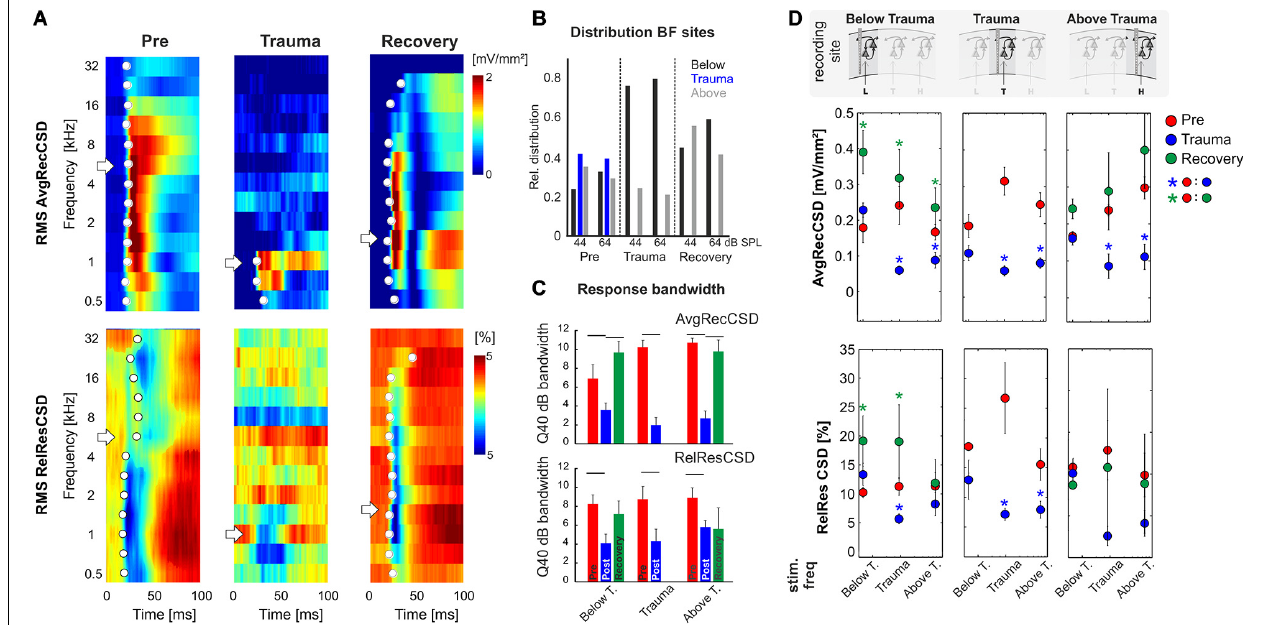
FIGURE 3 | (A) Representative example of AvgRecCSD (top) and RelResCSD (bottom) obtained after stimulation with varying sound frequencies at moderate sound level (64 dB SPL) prior to (left), after trauma induction (middle) and after 4 weeks of recovery (right). The respective BFs defined by the maximum AvgRecCSD peak amplitude are indicated by white arrows. Before trauma, the BF in the example was found to be 5.6 kHz. At the corresponding recording position, the BF after 4 weeks of recovery was decreased to 1.4 kHz. Onset latency of significant activation (2SD > baseline) at each sound frequency is indicated by white circle. (B) Distributions of the BF (based on granular sink S1 peak amplitude) determined at 44 as well as 64 dB SPL and measured at recording sites with BFs below, around and above the trauma frequency (bar colors) at the three time points directly before and after trauma induction as well as after 4 weeks of recovery. For Chi-Square-test results, see main text. (C) Response bandwidths before ( Pre ) and after ( Trauma ) the trauma and 4 weeks later ( Recovery ) measured by Q40dB values (in octaves) were calculated for the RMS values of the AvgRecCSD (top) and the RelResCSD (bottom). (D) Quantitative comparison of RMS values of AvgRecCSD (top) and RelResCSD (bottom) obtained after stimulation at moderate sound level (64 dB SPL) with sound frequencies below, at and above the trauma. Data prior to (red), after trauma induction (blue) and after 4–7 weeks of recovery (green) are plotted. For statistical results based on an rmANOVA and further explanation see main text and Tables 3.1–3.5 . Blue and green asterisks mark significant differences between groups identified by post hoc paired-sample Student’s t -test based on a Bonferroni-corrected level of significance due to 9 post hoc tests for each subpanel of α * = α /9 = 0.00556. Comparisons without asterisk are hence not significantly different